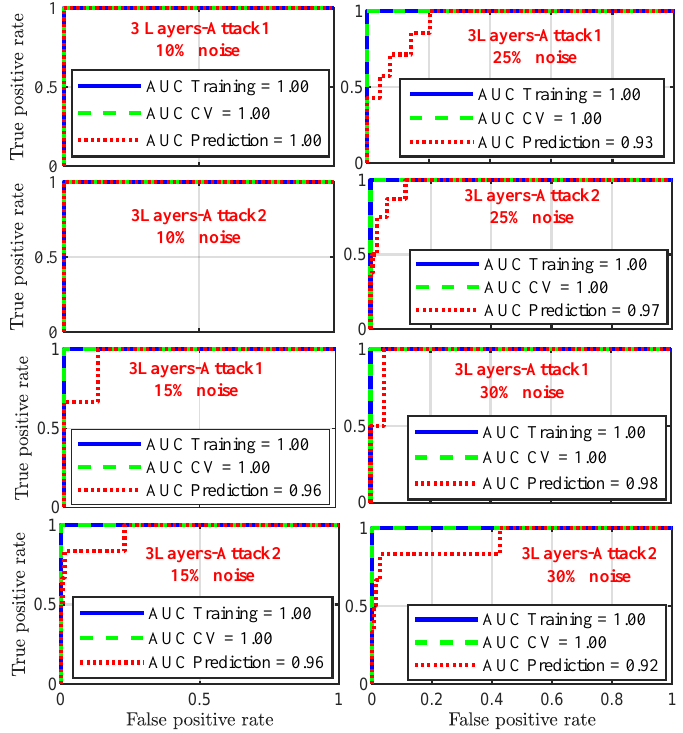
Figure 9. The ROC of various attack scenarios considering measurements noise levels. For a SNN, M N ≤ 10% does not impact the performance of the detection model under either attack scenarios. However, when the noise level is increased to 15%, the AUC of prediction drops to 96% in both attack scenarios. Moreover, numerical results shown in Tables 4 and 5 show that accuracy and recall are also deteriorated from 1.00 to 0.99 and 0.67 in attack 1 and 0.99 and 0.50 in attack 2, respectively. This is also true when the noise level is further increased to 30%.